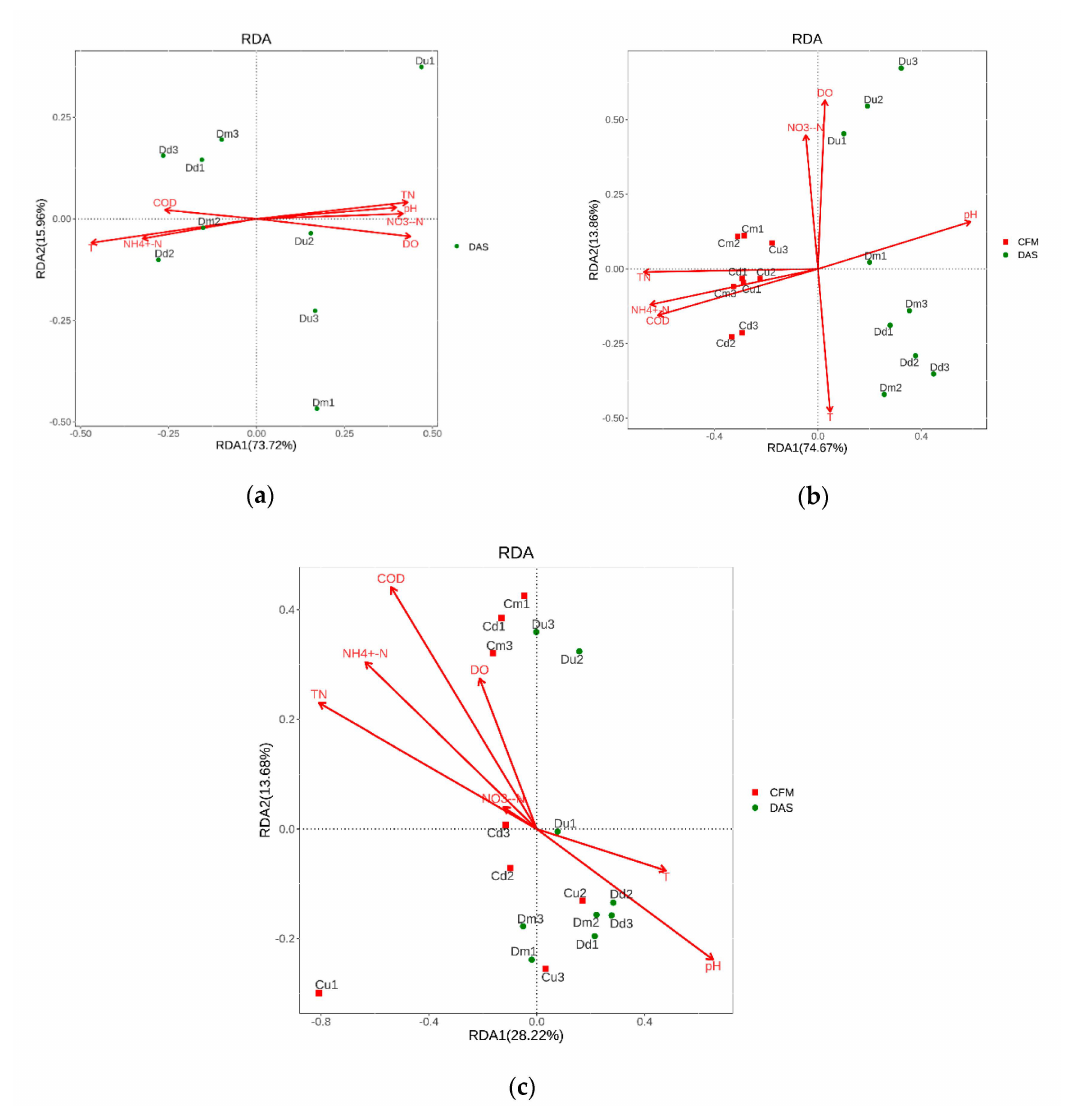
Figure 6. Ordination plots generated by redundancy analysis of ( a ) AOA, ( b ) AOB, and ( c )